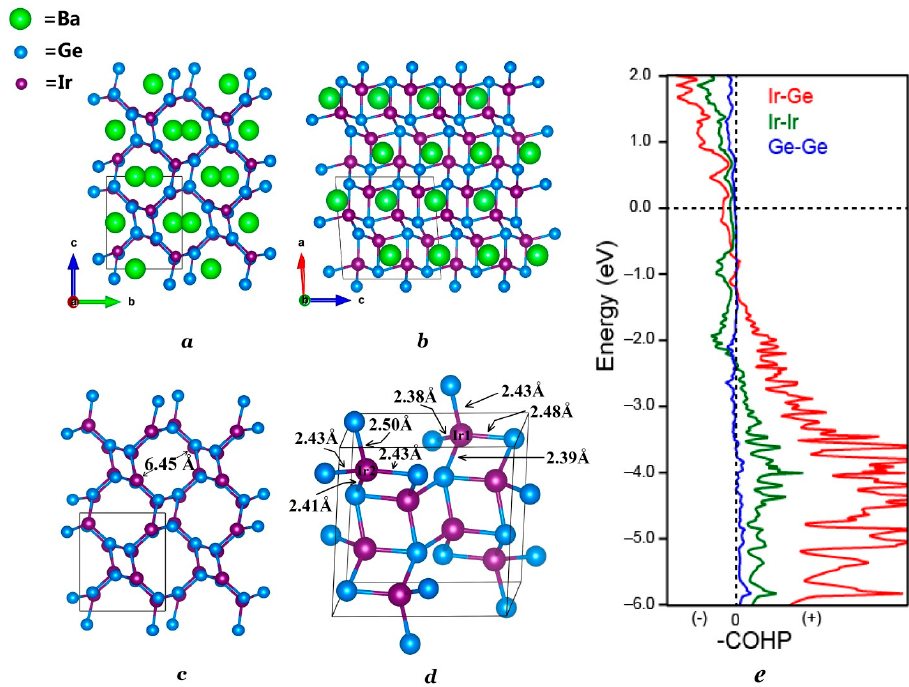
Figure 2. Crystal structure of monoclinic BaIr 2 Ge 2 refined by single crystal X-ray diffraction. ( a ) View down the a-axis; ( b ) View down the b-axis; ( c ) The IrGe framework. The channels running along the a-axis have a channel of diameter ~6.45 Å; ( d ) close-up of the framework structure showing the Ir-Ge bond lengths; ( e ) Crystal orbital hamilton populations (-COHP) calculation emphasis on the Ir-Ge, Ir-Ir, and Ge-Ge interactions.